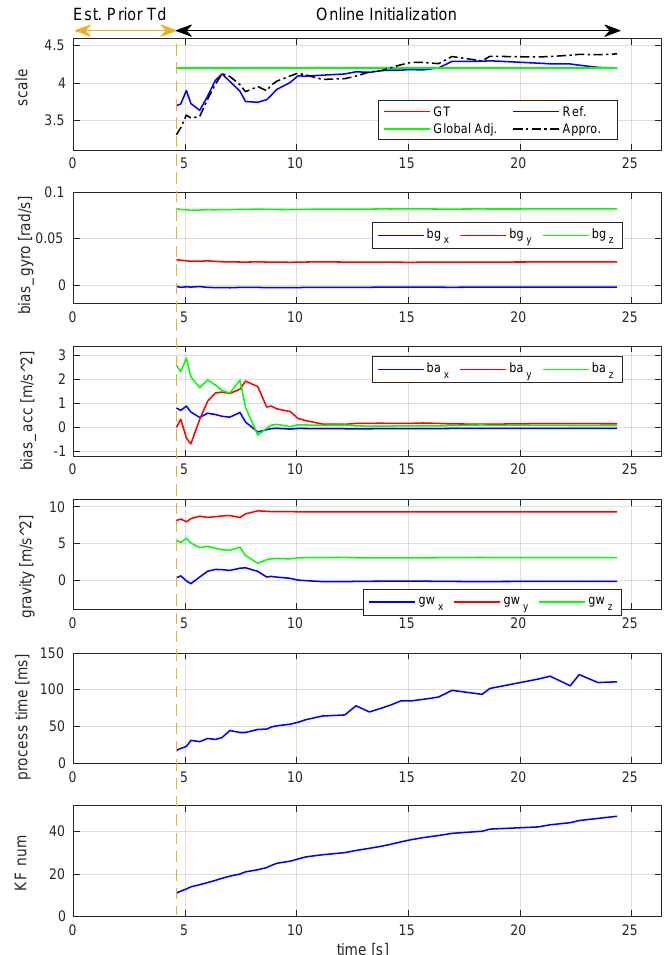
Figure 10. The scale, gyroscope bias (bias_gyro), accelerometer bias (bias_acc), gravity vector, processing time expended by each execution, and keyframe number (KF num) using the V2_01